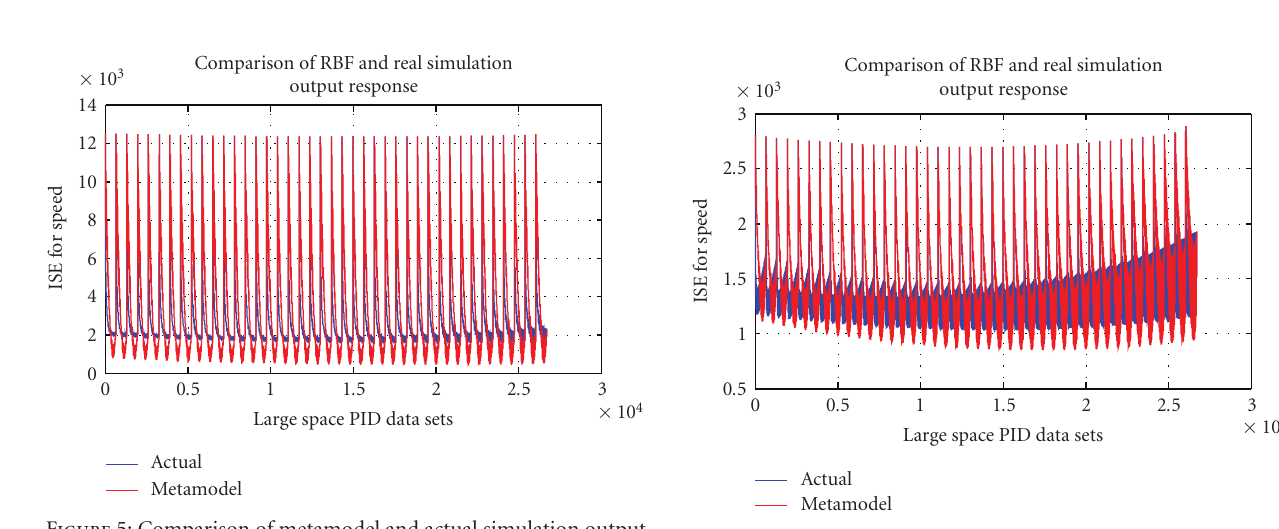
Figure 6: Comparison of metamodel and actual simulation output for linear